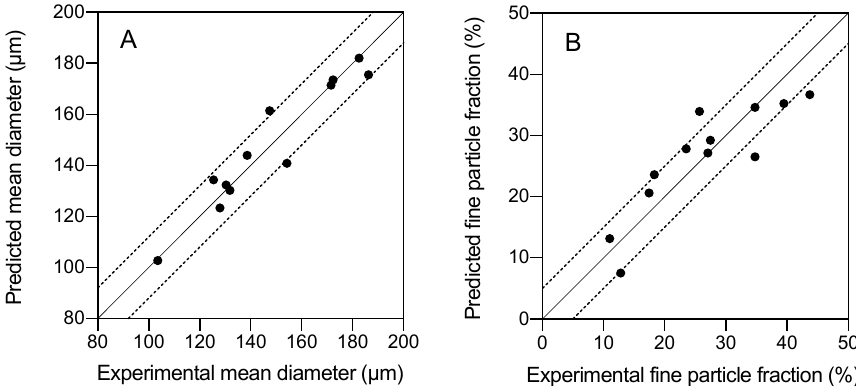
Figure 7. Parity plots of the predicted and experimental values of ( A ) mean particle size and ( B ) % of fine particles. Continuous diagonal line is a 45°-slope line; dotted lines correspond to an envelope of tolerance of 10%.